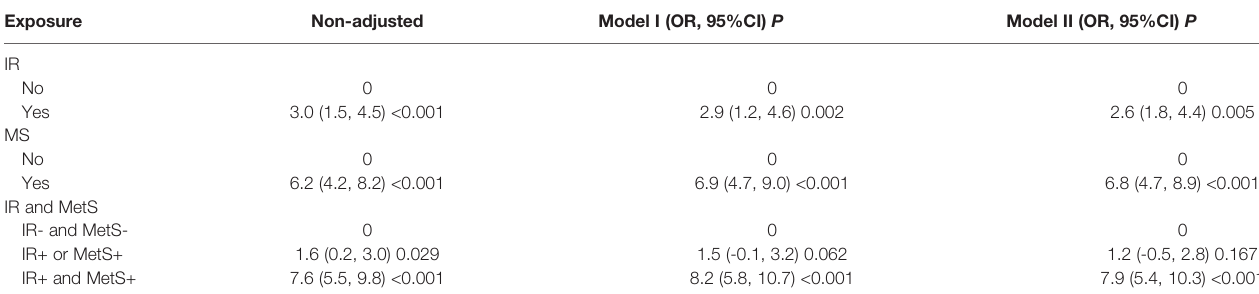
TABLE 4 | Logistic regression models evaluating the relationship between metabolic features and RCR time.